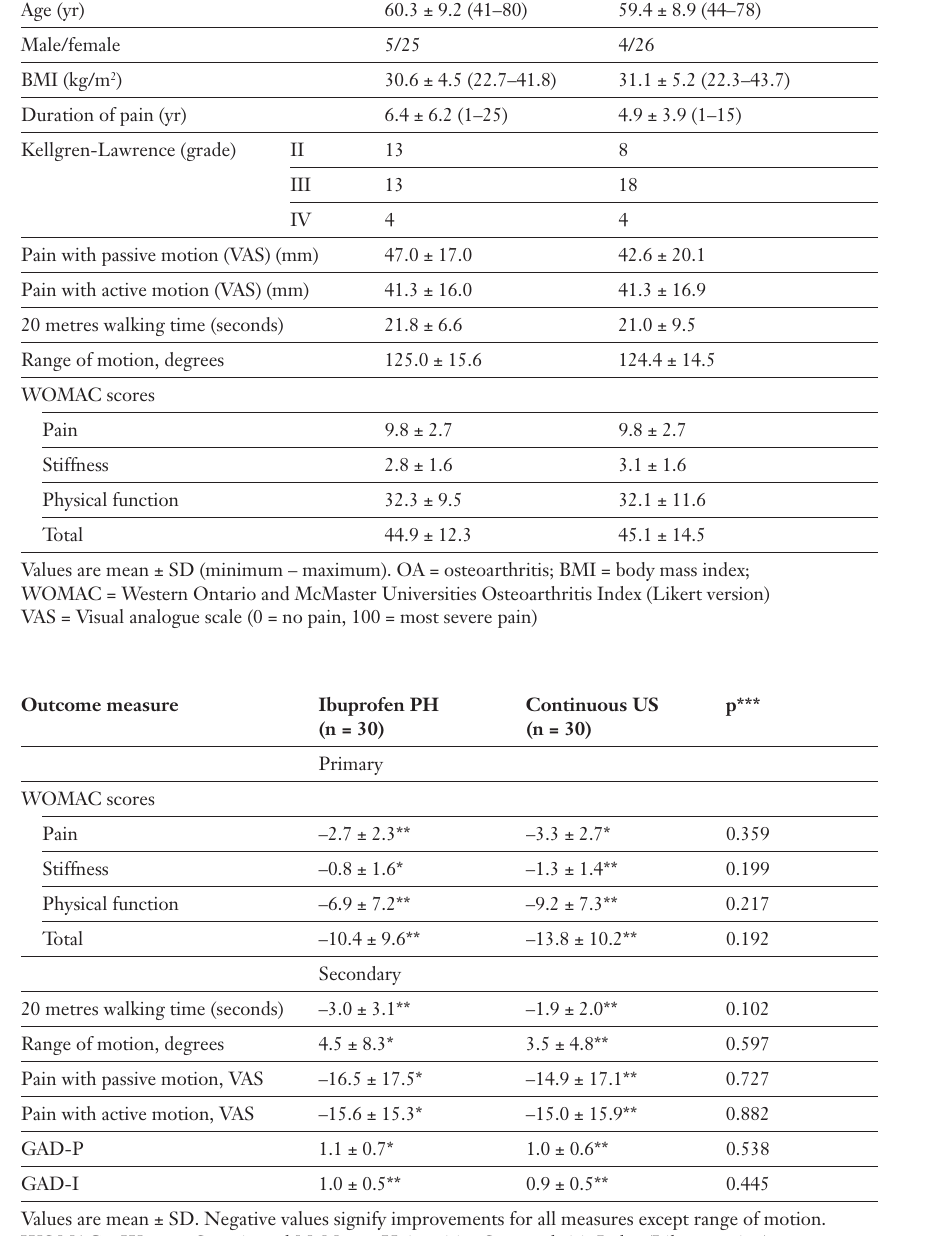
group; *** difference between the two treatment groups.